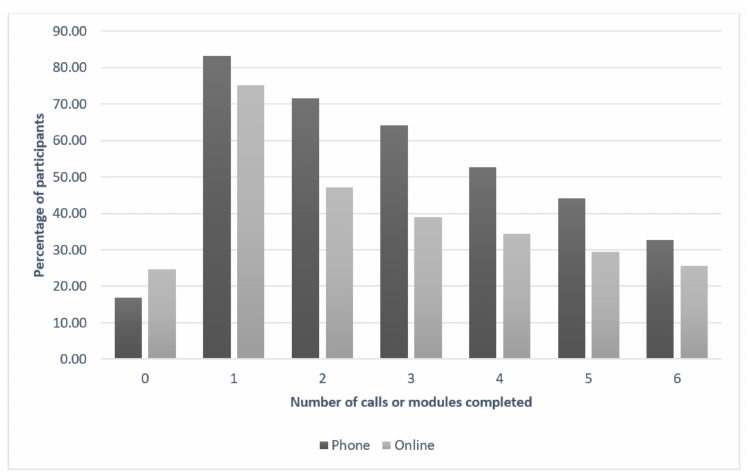
Figure 2. Results of primary outcome (CDQ score, fruit and vegetable daily intake, and fruit and vegetable guideline compliance).